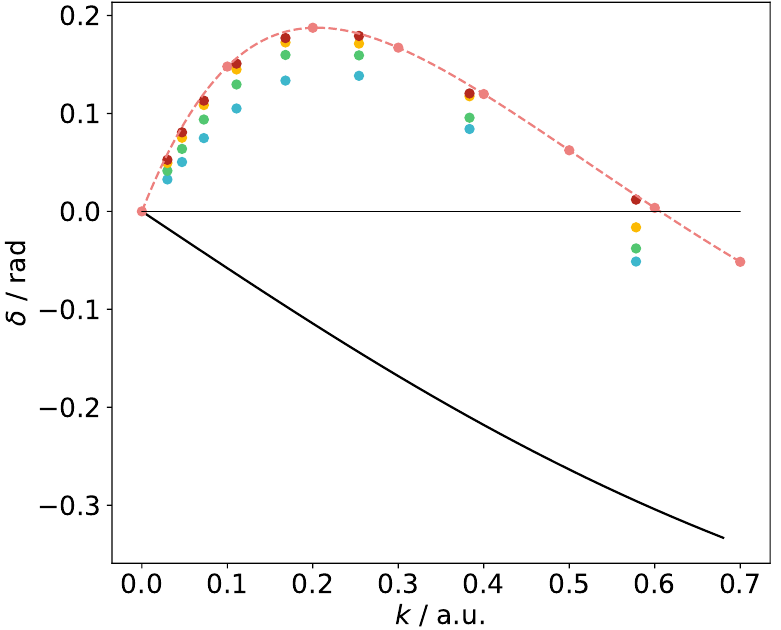
Figure 6. Positron–hydrogen s -wave scattering phase shifts obtained using various numbers of terms with γ i (cid:54) = 0 in the wavefunction (colored circles, blue: one term, green: three terms, yellow: five terms, red: nine terms). Details of the parameters used in each wavefunction can be found in Appendix B. Pink circles are the Kohn variational calculations of Humberston et al. [24], which are connected by the dashed line to guide the eye. The black solid line is the result of the frozen-target approximation. In Figure 7, the final phase shifts obtained using all nine correlation (i.e., nonzero γ i ) terms are displayed. Compared with an interpolation of the Kohn variational results of Humberston et al. [24], agreement is seen to within 8 × 10 − 3 rad. In Table 2, the